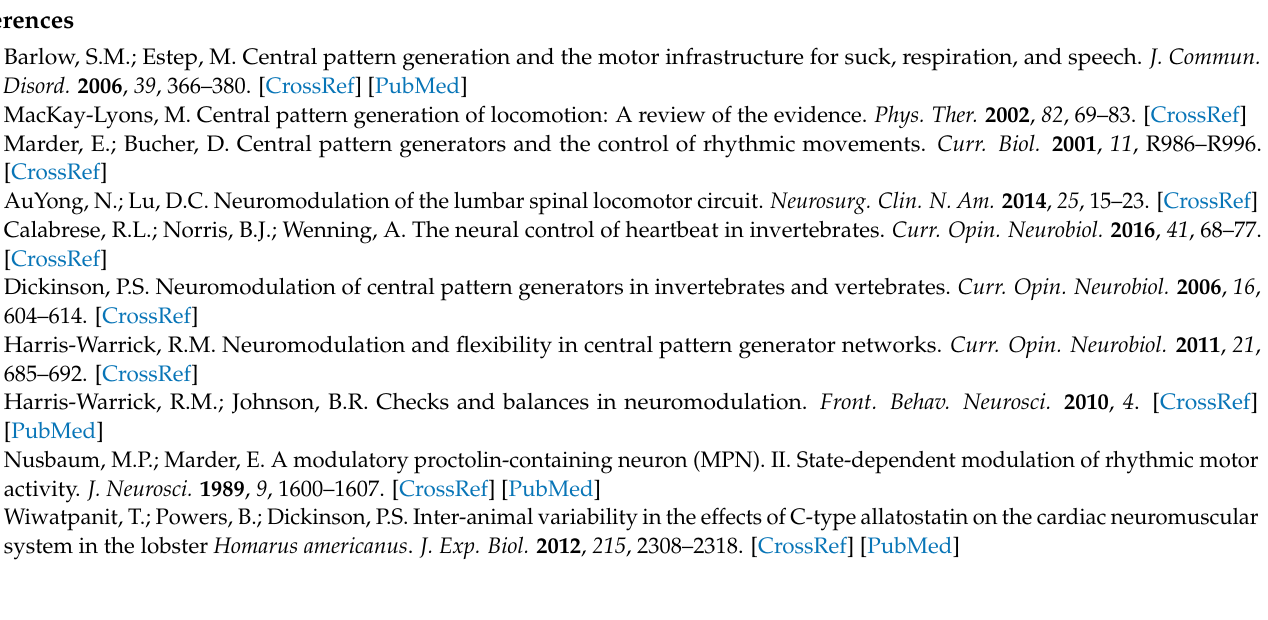
Table S1: Bioinformatic analysis of Homarus americanus ASTCRs; Table S2: Top 5 BLASTx hits using putative Homarus americanus ASTCRs as query sequences; Table S3: BLASTn analysis of Homarus americanus ASTCR sequences against a cardiac ganglia specific transcriptomic dataset; Table S4: Spearman correlation statistics for differential receptor expression; Table S5: tBLASTn analysis of tissue-specific Homarus americanus transcriptomic datasets; Table S6: Accession numbers of proteins used in maximum likelihood phylogenetic analyses; Table S7: Oligonucleotide primers used in this study; Table S8: Accession numbers of proteins used in phylogenetic analyses using the full receptor complement from two